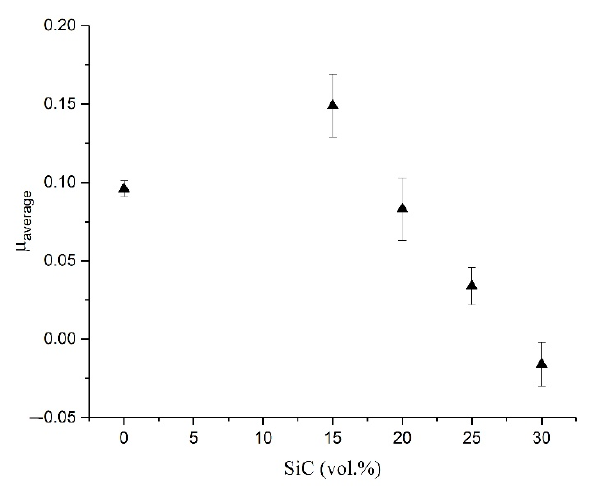
Figure 6. Coe ffi cient of friction as a function of SiC additions. Figure 6. Coefficient of friction as a function of SiC additions. Table 4. Approximate wear track sizes for the study’s